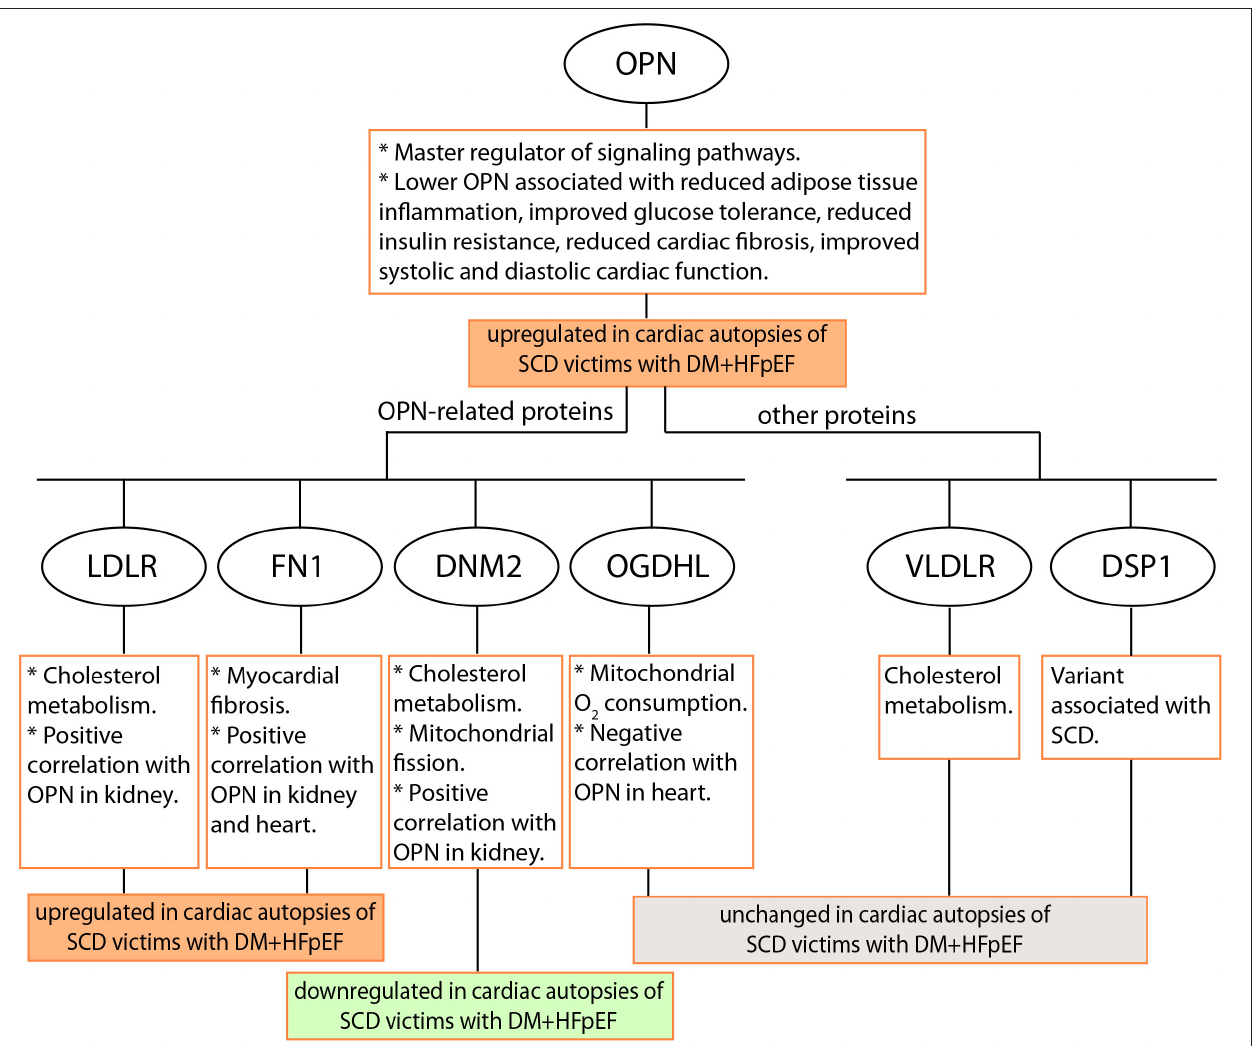
FIGURE 6 | Schematic of the study. Seven proteins were investigated by immunostaining in cardiac autopsies from sudden cardiac death (SCD) victims with Heart Failure with preserved Ejection Fraction (HFpEF) and Type 2 Diabetes Mellitus (DM). OPN, Osteopontin; LDLR, Low Density Lipoprotein Receptor; DNM2, Dynamin-2; FN1, Fibronectin 1; OGDHL, 2-Oxoglutarate Dehydrogenase Like; VLDLR, Very Low Density Lipoprotein Receptor; DSP, Desmoplakin.